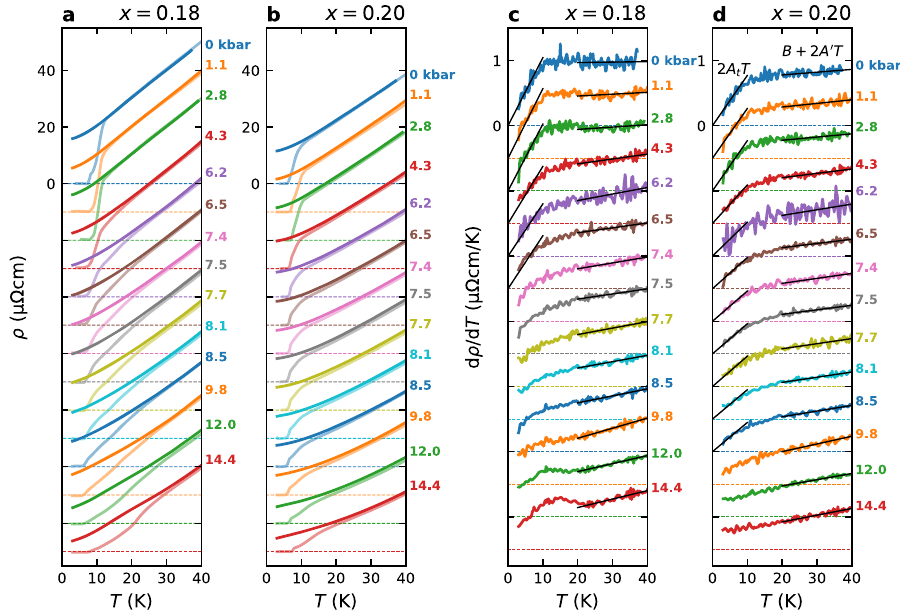
Fig. 1 Pressure dependence of the high- fi eld in-plane resistivities of FeSe 1- x S x beyond the nematic quantum critical point. a , b Zero- fi eld resistivity ρ (0, T ) (pale curves) and high- fi eld resistivity ρ (35 T, T ) (dark curves) measured at indicated pressures p between 0 and 14.4 kbar for x = 0.18 ( x = 0.20) and up to a temperature T of 40 K with magnetic fi eld H and current I both oriented in-plane and parallel to each other ( H // I // ab ). The curves have been offset by 10 µ Ω cm for each subsequent pressure for clarity. c , d Corresponding fi rst derivatives of the high- fi eld resistivity for doping x = 0.18 ( x = 0.20) at the same pressures as those in a , b . For clarity, the curves have been offset by 0.5 µ Ω cm K − 1 at each pressure. The dashed lines indicate the ρ = 0 or d ρ / d T = 0 position of each curve. In panels c , d , the black lines are straight-line fi ts to the lowest temperature data chosen to both avoid the crossover to T + T 2 behavior at ~10 K and the onset of superconductivity at low temperatures and to the higher temperature data above 20 K from which the resistivity coef fi cients A t ( A ), B , and A ′ have been deduced. The enhancement of superconductivity prevents A t from being determined at the highest applied pressures. The increasingly broad superconducting transitions manifest themselves as shallow peaks in the derivatives that are most visible in d ρ / d T ( x = 0.18) above 9.8 kbar (panel c ) but may in fl uence the data at lower pressures as well. The fi ts at low- T have been forced through the origin. The small fi nite intercepts due to superconductivity at intermediate pressures are accounted for in the